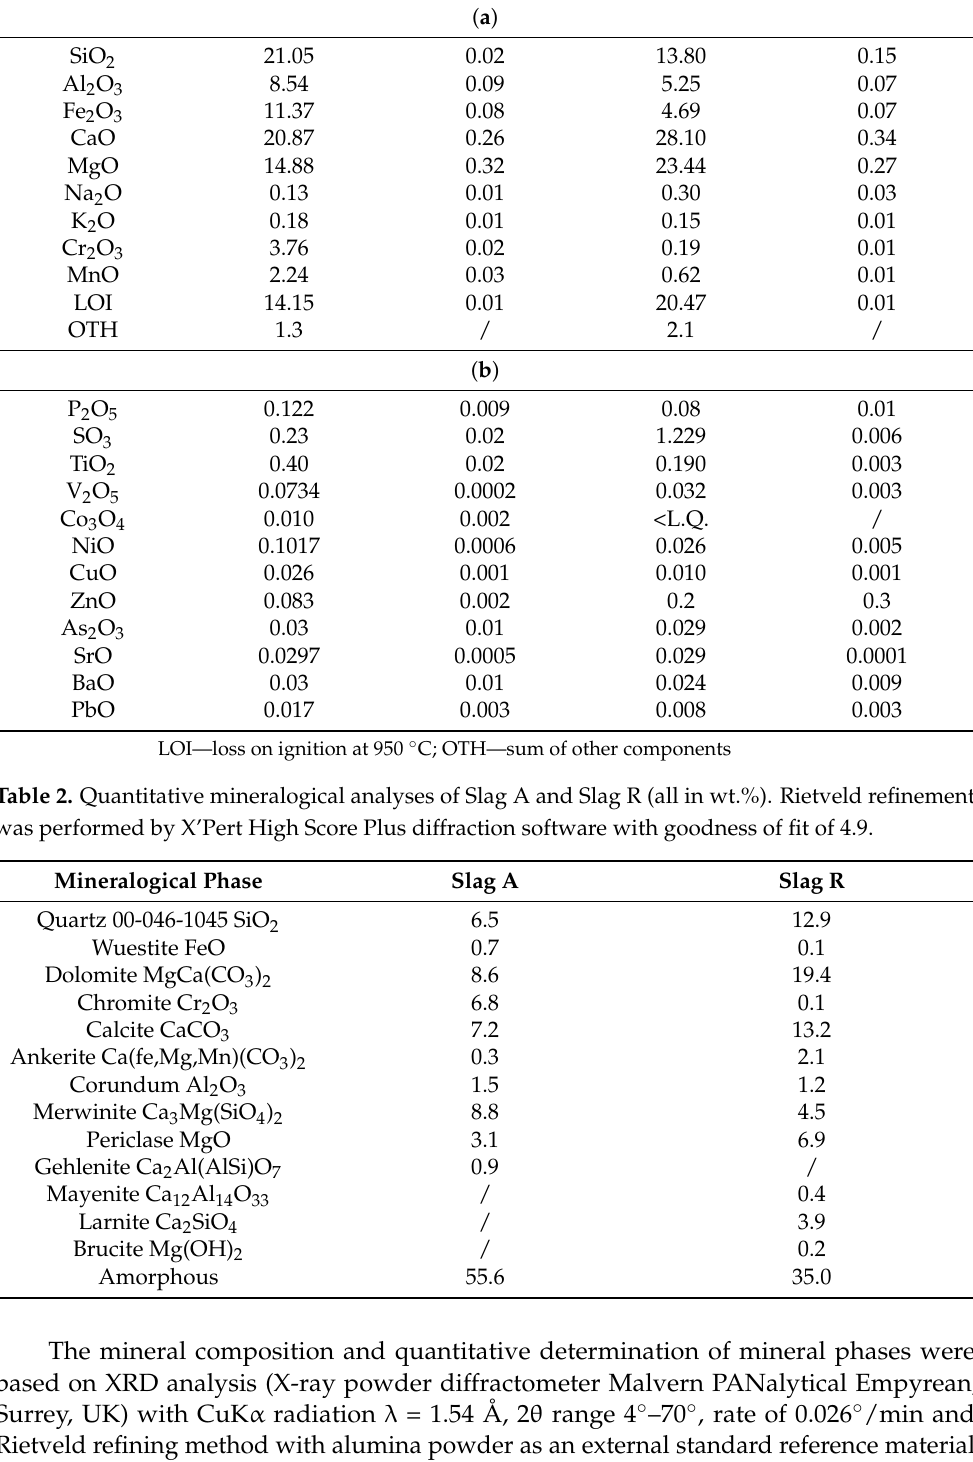
Table 1. Chemical composition of Slag A and Slag R, ( a ) main and ( b ) other elements. Oxides (wt.%)